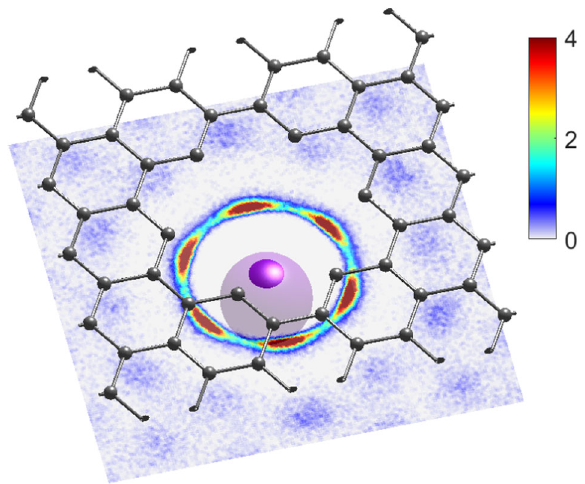
Fig. 1 Model setup. A hexagonal pore in pristine graphene (grey balls and sticks) and a K + ion (purple sphere) centred at Z = − 0.4 nm. The colour plane represents the density pattern of water oxygen atoms in the plane at Z = − 0.28 nm. (There will be comparable colour planes at other Z values.) The colours indicate density values relative to the bulk, brown being the highest (4) and dark blue being the lowest (0) value. The density has been evaluated by MD simulation, and it is compared with theory, Eq. (4), in Supplementary Fig.